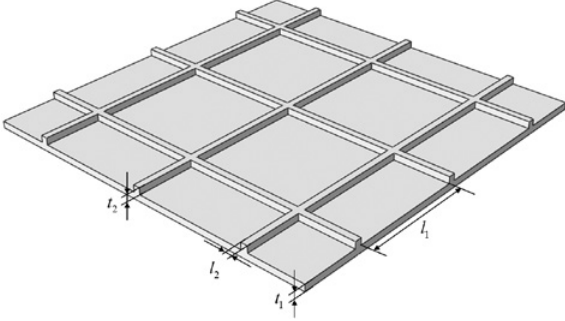
Figure 13: The temperature and degree of cure evolutions of the AGS composite